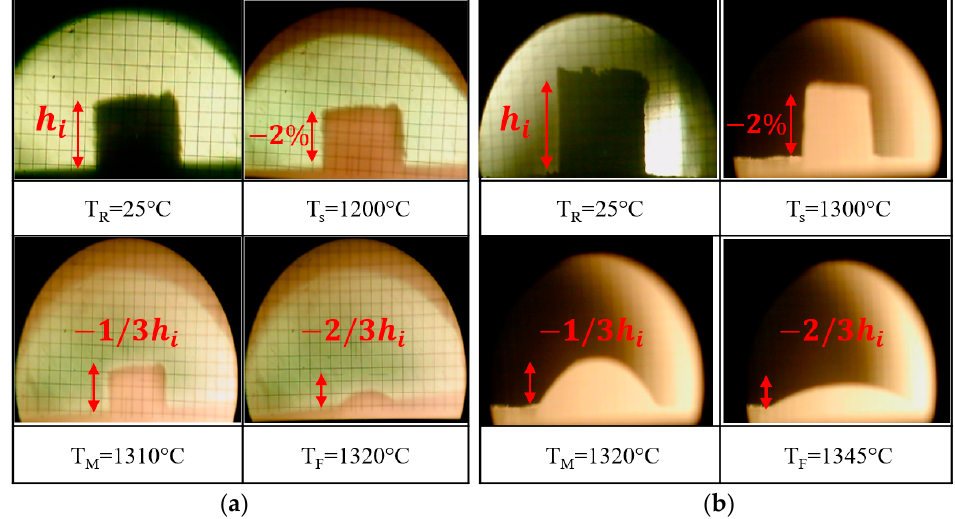
Figure 6. Hot-stage microscopy images of ( a ) R slag, and ( b ) S slag at selected temperatures ( − 2% h i —sintering, − 1/3 h i —melting point, − 2/3 h i —flow point).